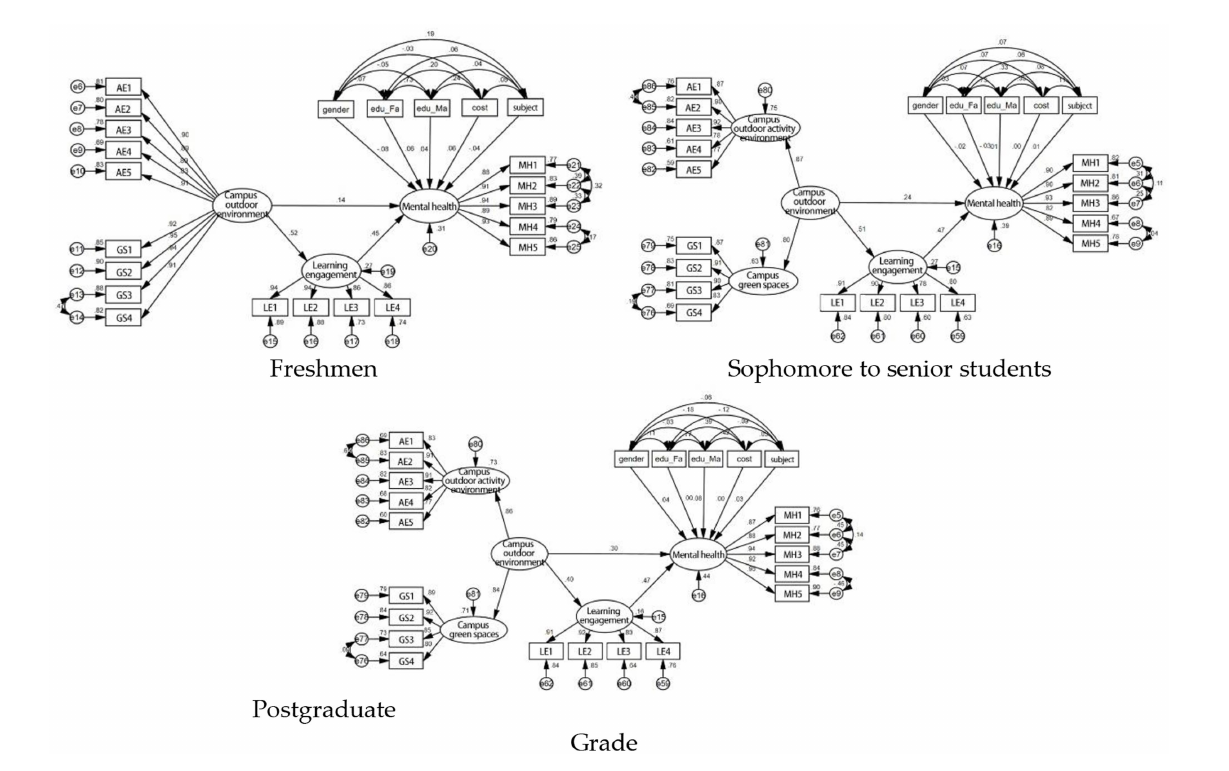
FIGURE 2 Comparison of standardized road maps of different university student population